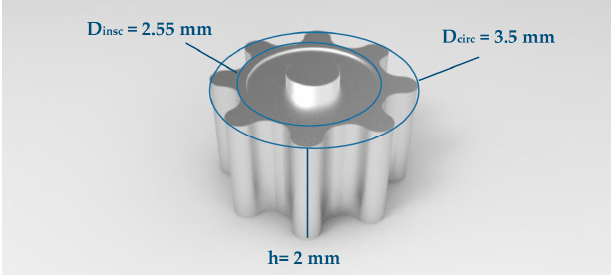
Figure 1. Experimental micro-gear design used in this work.